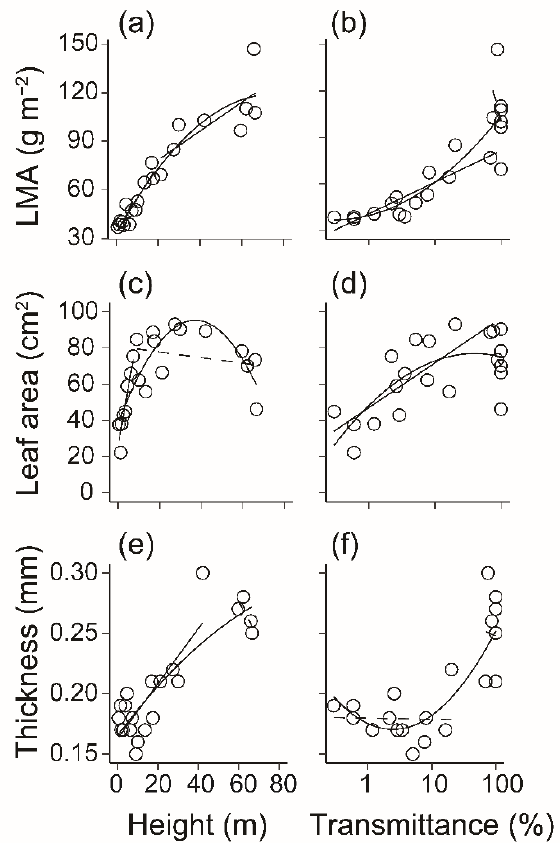
Figure 6. Leaf morphological traits such as LMA, leaf area, and thickness plotted against tree height ( a , c , e ) and light (represented as ln(%TRANS)) ( b , d , f ). Lines indicate the linear piecewise regression results; solid lines denote significant relationships ( P < 0.05), and broken lines denote nonsignificant relationships. The curves indicate the quadratic regression results. Note that a natural log scale is used on the X-axis in panels ( b , d ) and ( f ).